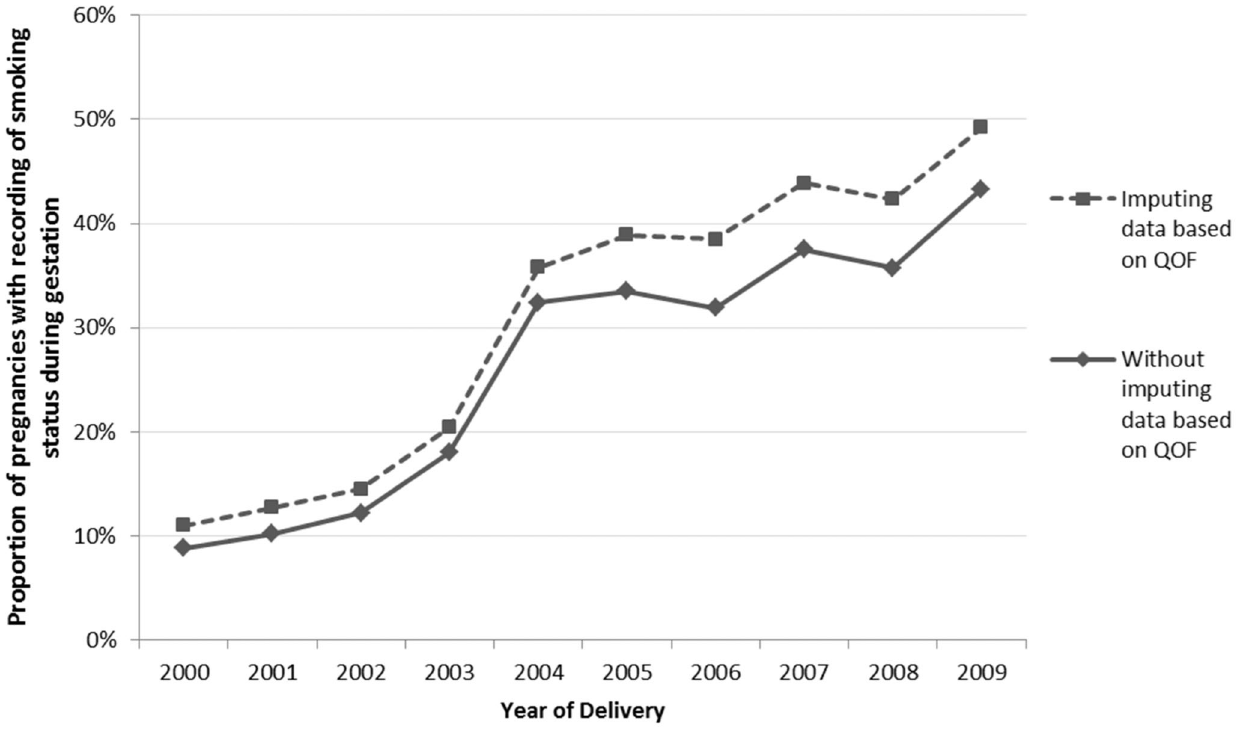
Figure 1. Annual proportion of pregnancies in THIN with smoking status recorded during gestation (2000–2009).